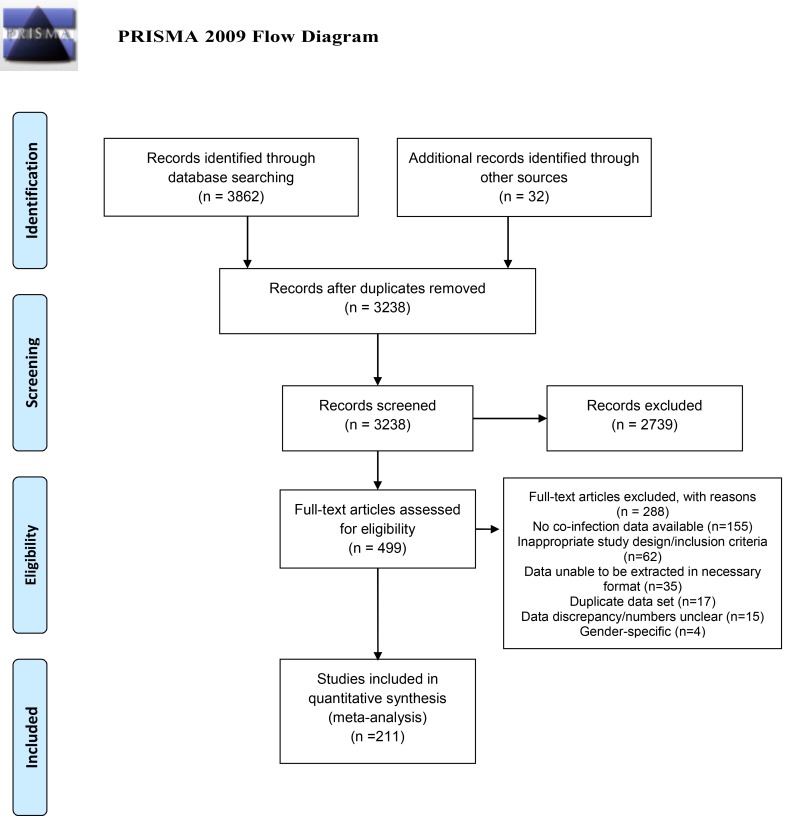
Flowchart of study selection process.